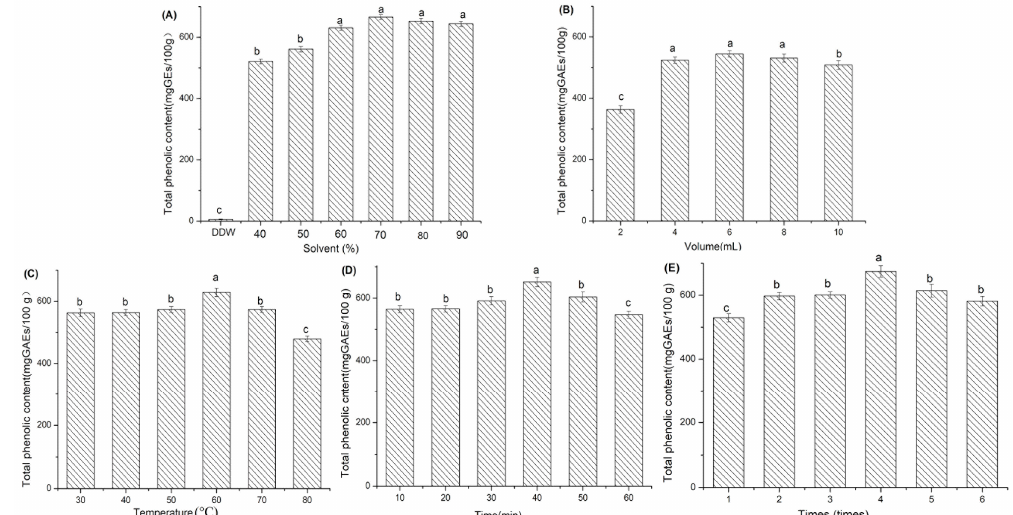
Figure 1. Optimization of extraction conditions based on the concentration of total phenolic compounds. The effects of ( A ) solvent, ( B ) volume, ( C ) temperature, ( D ) time, and ( E ) replicates are shown (values are presented in mean ± standard deviation ( n = 3)). Different superscript letters (a–c) in the coordinate axis denotes significant differences at p < 0.001 (* p < 0.05).